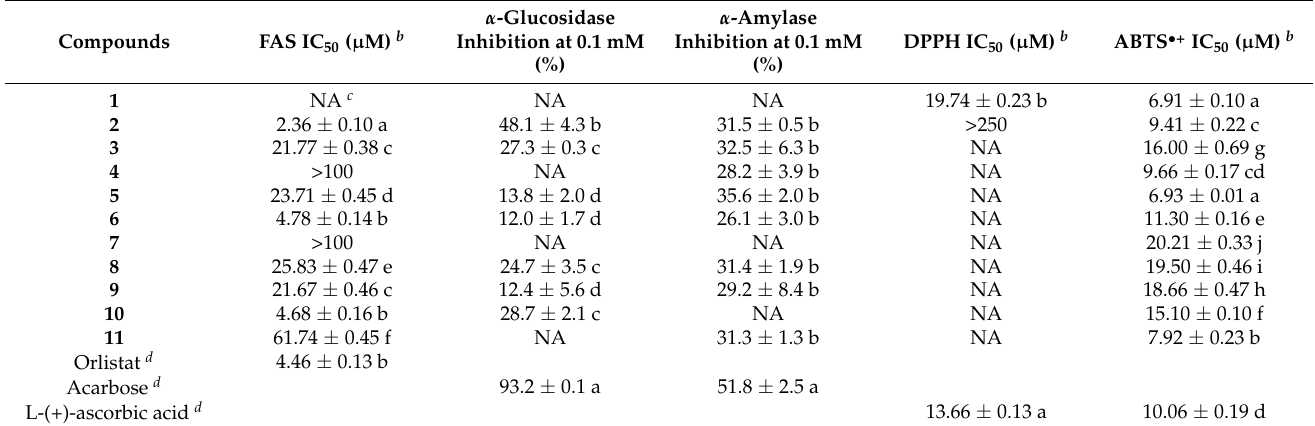
a Data are expressed as mean ± SD ( n = 3). Means with the same letter are not significantly different (one-way analysis of variance, α = 0.05). b IC 50 : the final concentration of sample needed to inhibit 50% of enzyme activity or scavenge 50% of free radical. c NA: no activity. d Positive